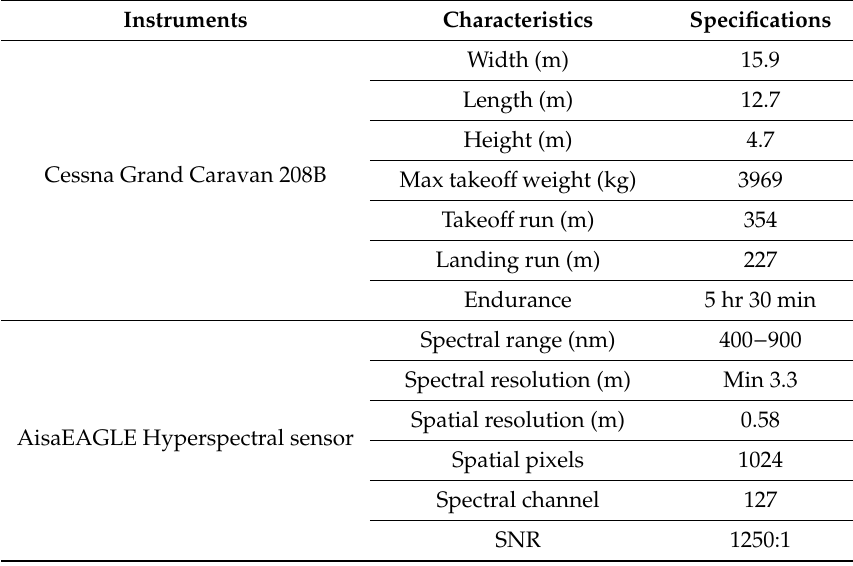
Figure 2. ( a ) Cessna Grand Caravan 208B, ( b ) AisaEAGLE hyperspectral sensor, and ( c ) digital mapping camera (DMC). Table 1. Airborne and hyperspectral sensor specifications.